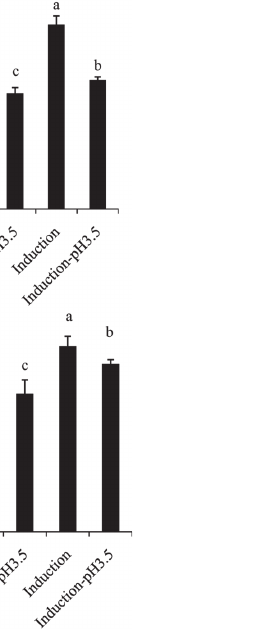
Fig 4. Comparison of the physiological characteristics of Bifidobacterium in the different treatment groups. The same letters indicate no significant difference among the detected values ( p > 0.05).Biological repeats, n =